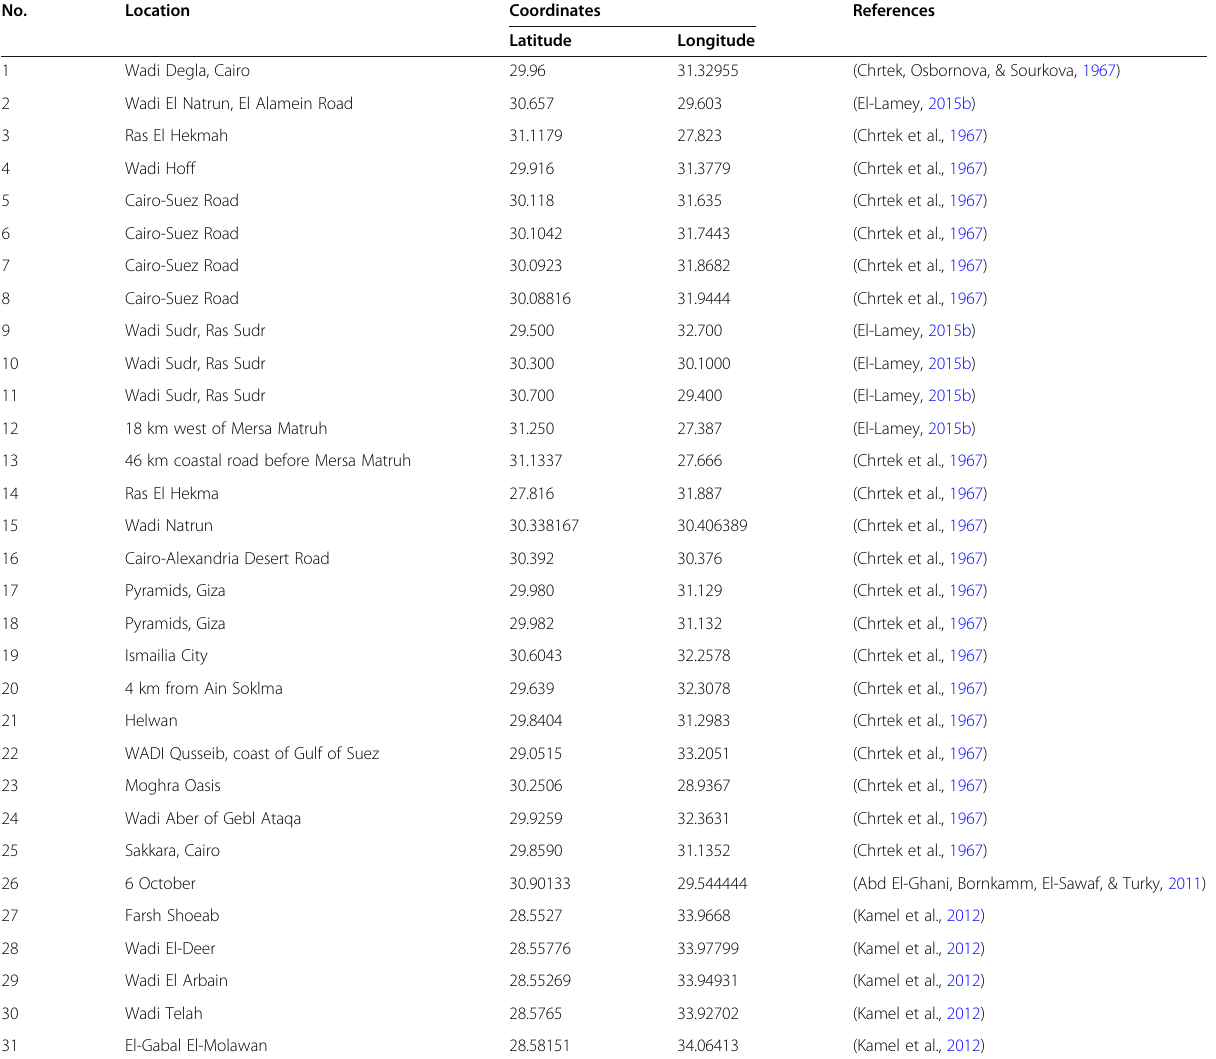
Table 1 The recorded locations of D. tortuosa in Egypt